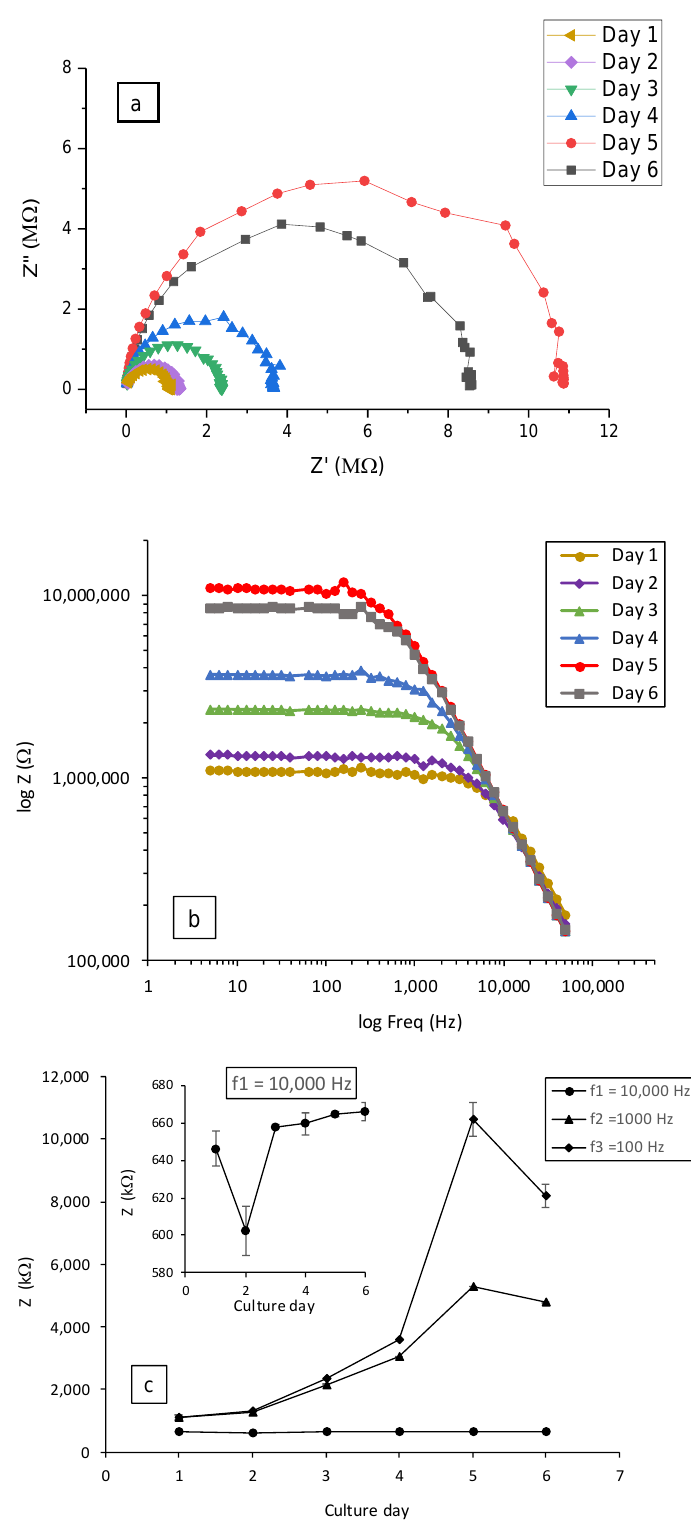
Figure 7. Impedance measurements (disk design, carbon BQ242 + IrOx 2 wt% electrodes) during 6 days of culture under flow rate of 7 µL·min −1 : ( a ) Nyquist plots, ( b ) Bode plots and ( c ) impedance (Z) as function of the culture day and zoom on the plot at frequency of 10 kHz. Frequency scanning range of 50 kHz–5 Hz. Cells were exposed to SDS at a final concentration of 0.5 mM after the TEER measurement of day 5.